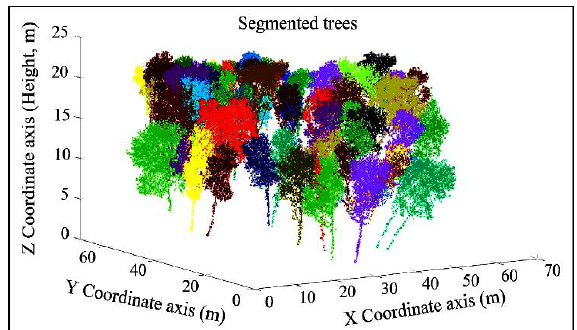
Figure 11. Final segmentation results related to trees from half of plot